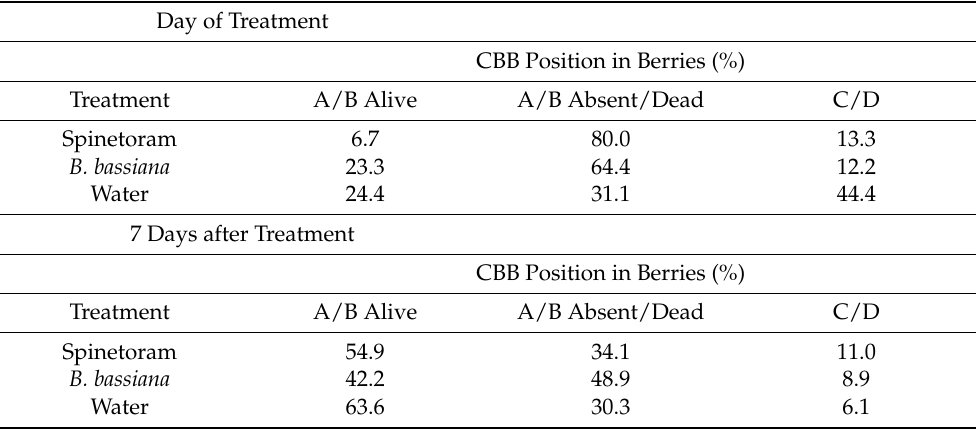
Table 3. Coffee berry borer (CBB) position 14 days after treatment with spinetoram, Beauveria bassiana , or water in berries infested on the day of treatment, and new berries infested 7 and 14 days after